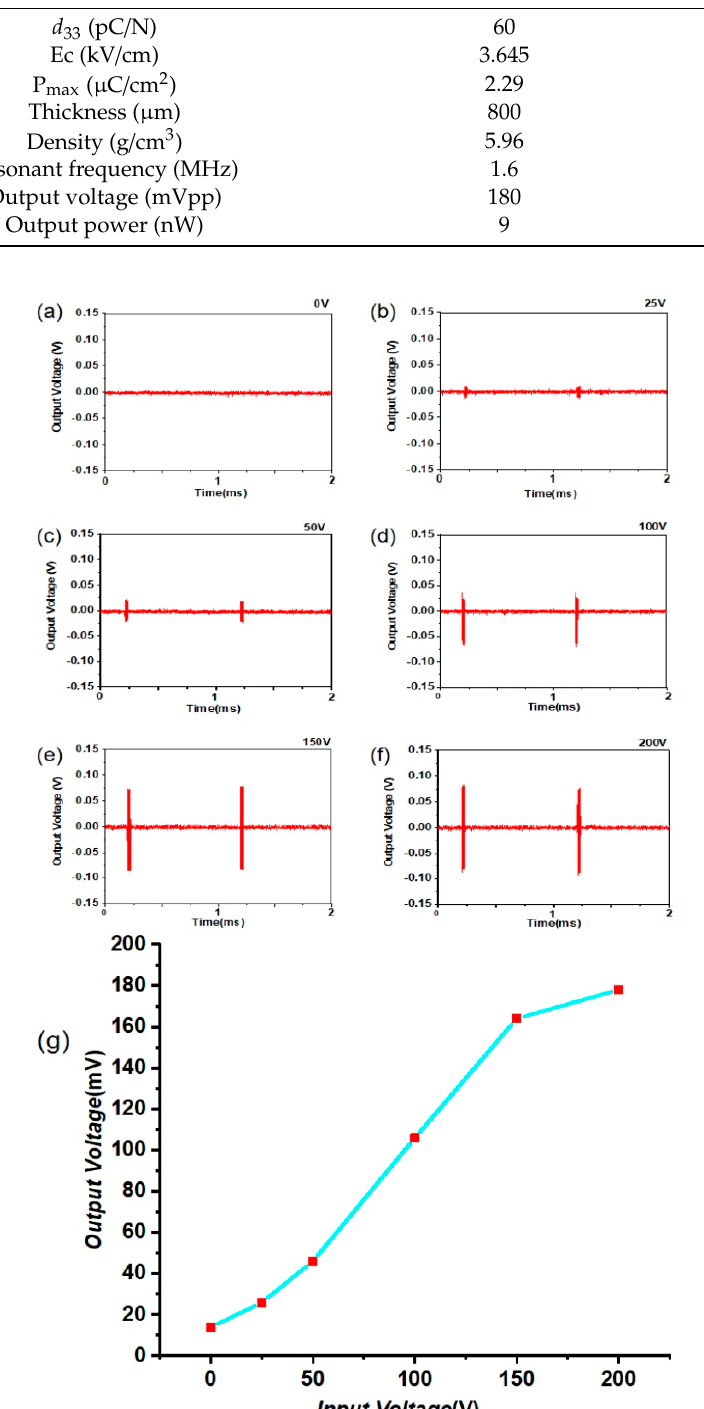
Figure 8. Output voltage amplitudes of the device over time for different input voltages of ( a ) 0 V; ( b ) 25 V; ( c ) 50 V; ( d ) 100 V; ( e ) 150 V; and ( f ) 200 V; ( g ) Trend of the output voltage.